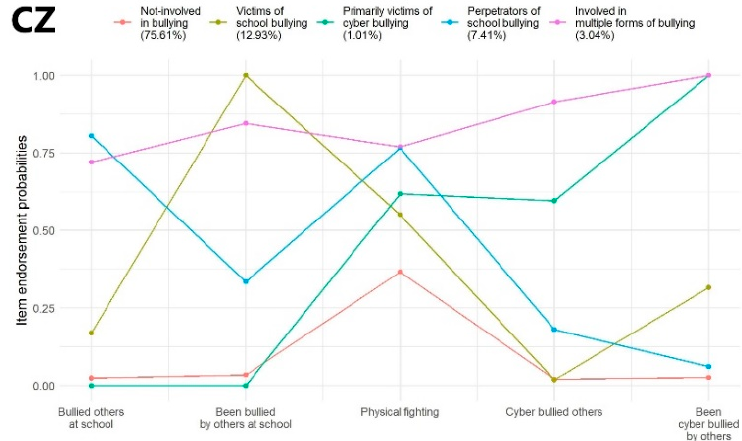
Figure 1. Latent class profile of Czech Republic.